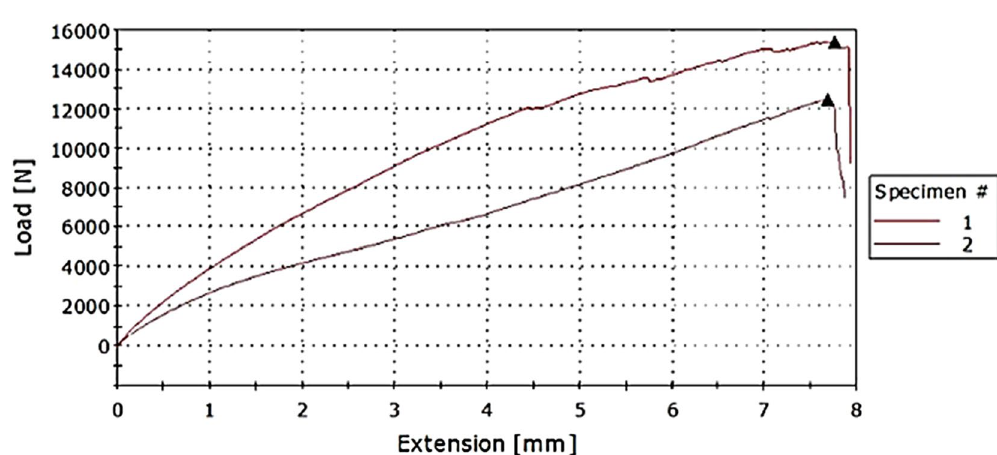
Figure 3. Tensile strength against sample type (1) Alternating (2) All sisal layers in the middle